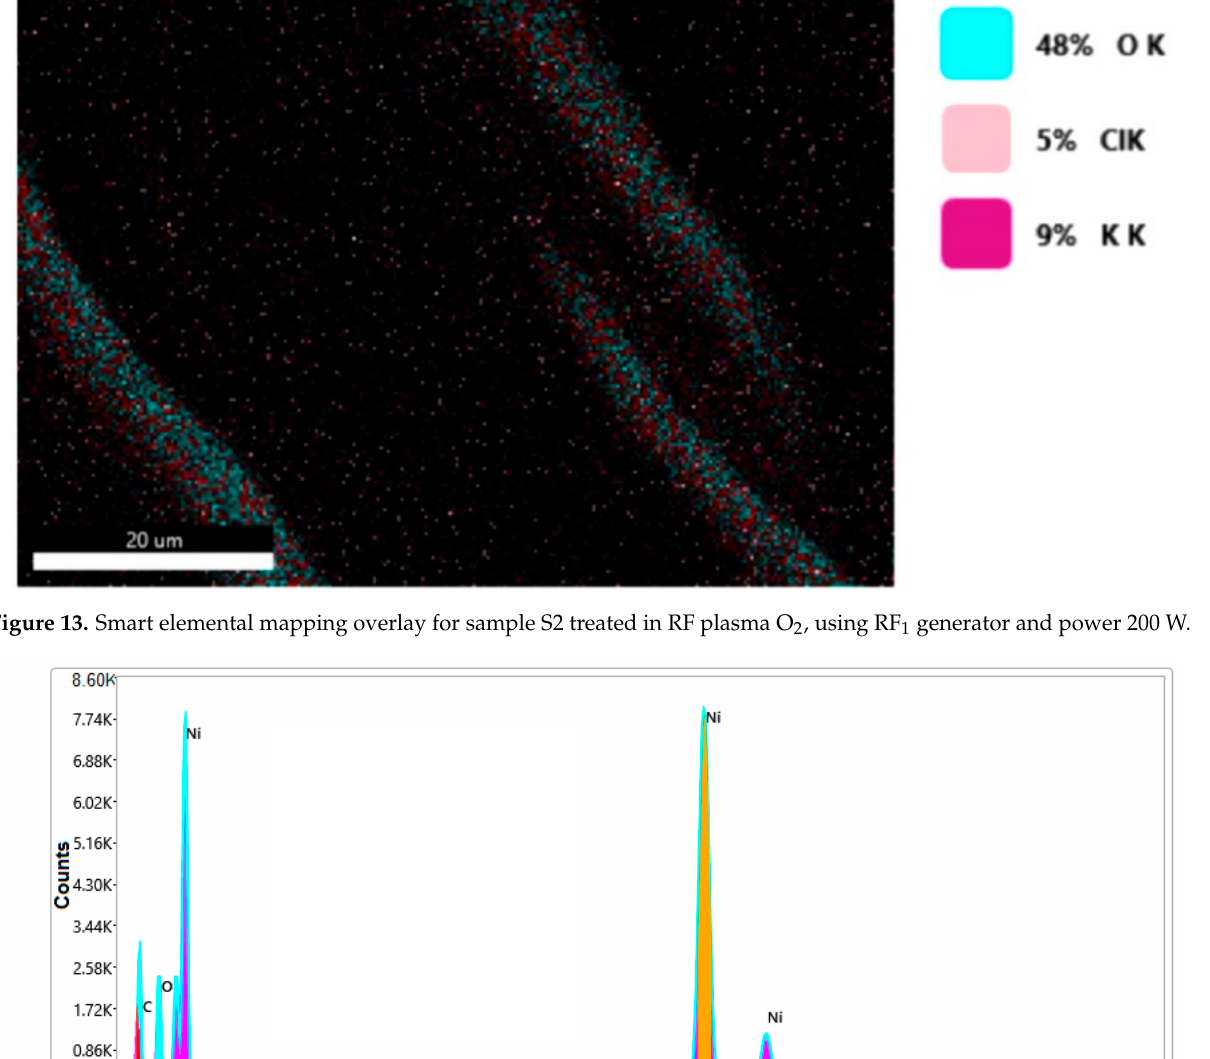
Figure 14. ESD spectra and elemental overlay for sample S2 treated in RF plasma O 2 , using RF 1 generator and power 200 W and Ni paste.